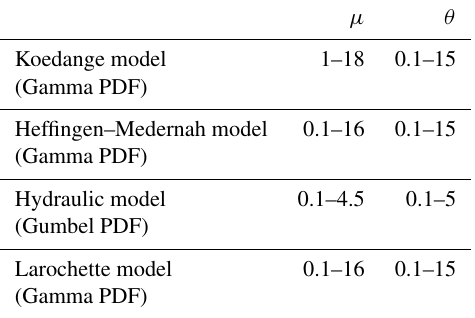
Table 3. Model’s parameter